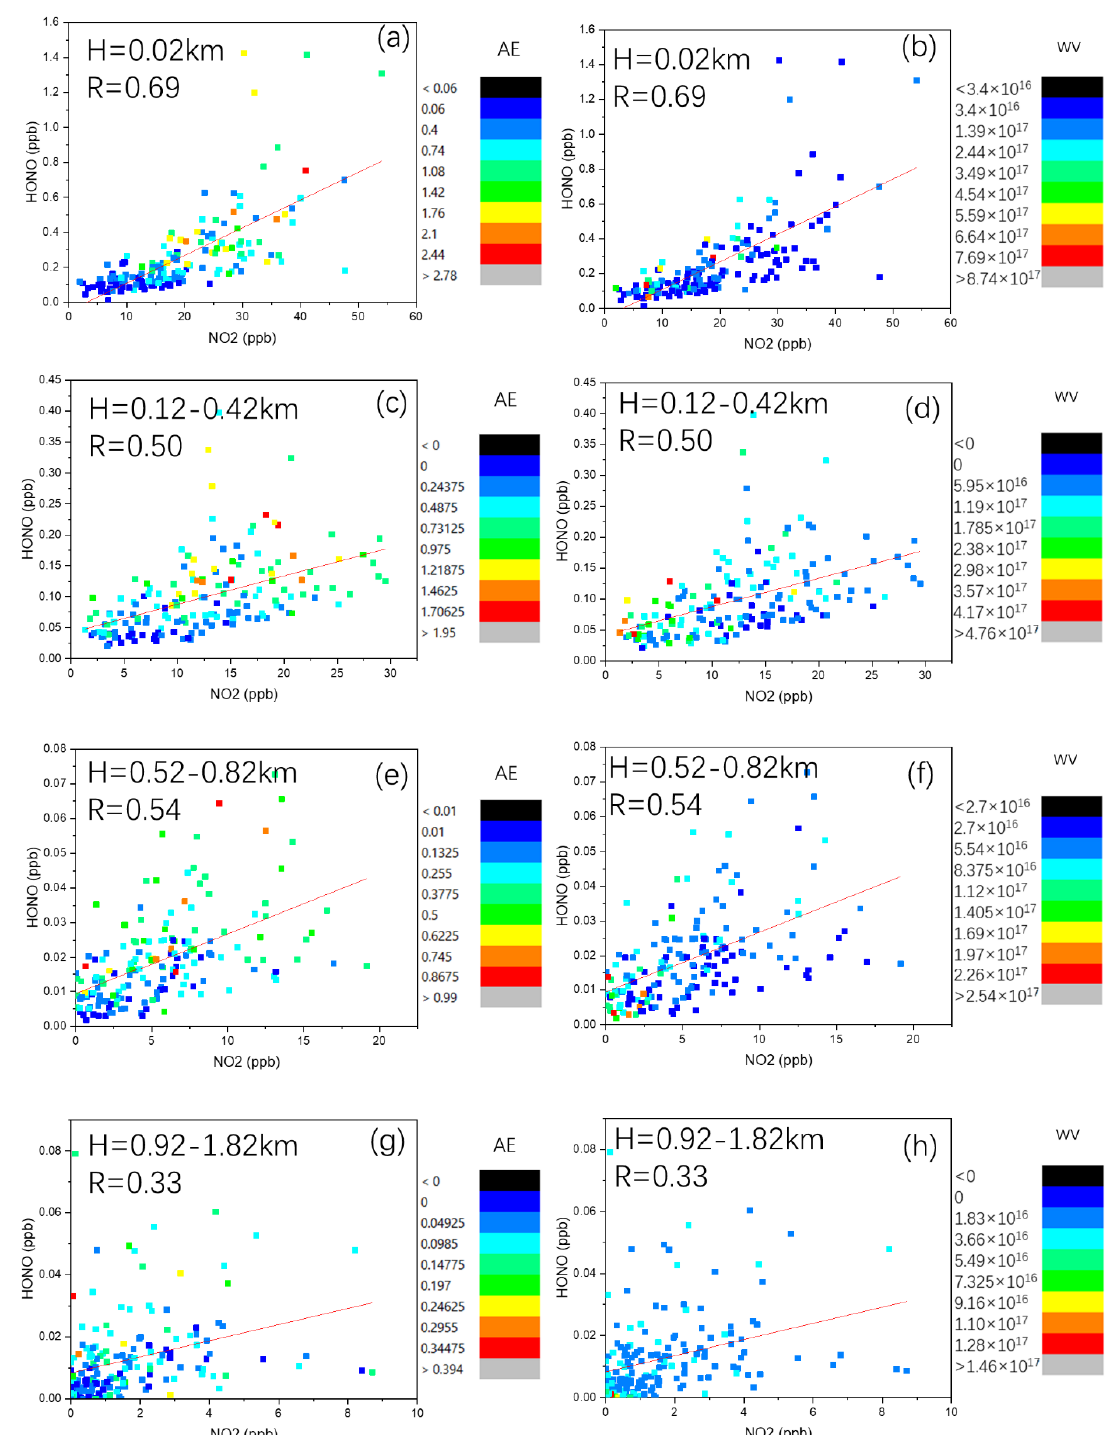
Figure 11. Correlations between HONO and NO 2 concentrations in each layer, ( a , b ) is the bottom layer 0.02 km; ( c , d ) is the lower layer 0.12–0.42 km; ( e , f ) is the middle layer 0.52–0.82 km; ( g , h ) the higher layer 0.92–1.82 km.